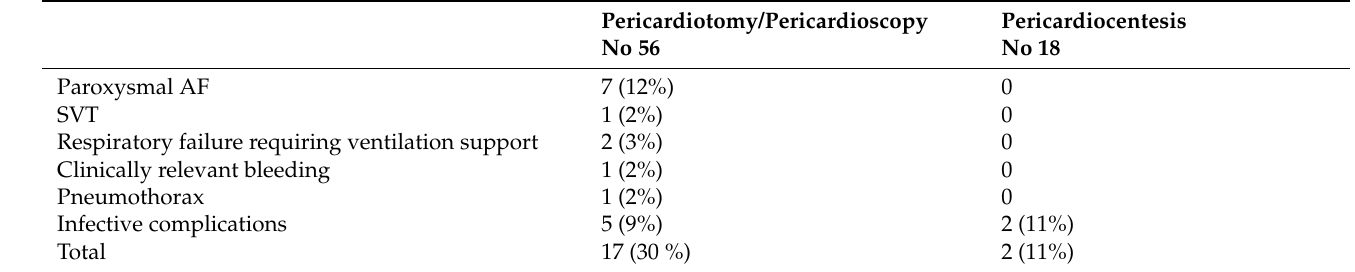
Table 2. Rate of complications in the group of patients treated with surgical intervention compared to